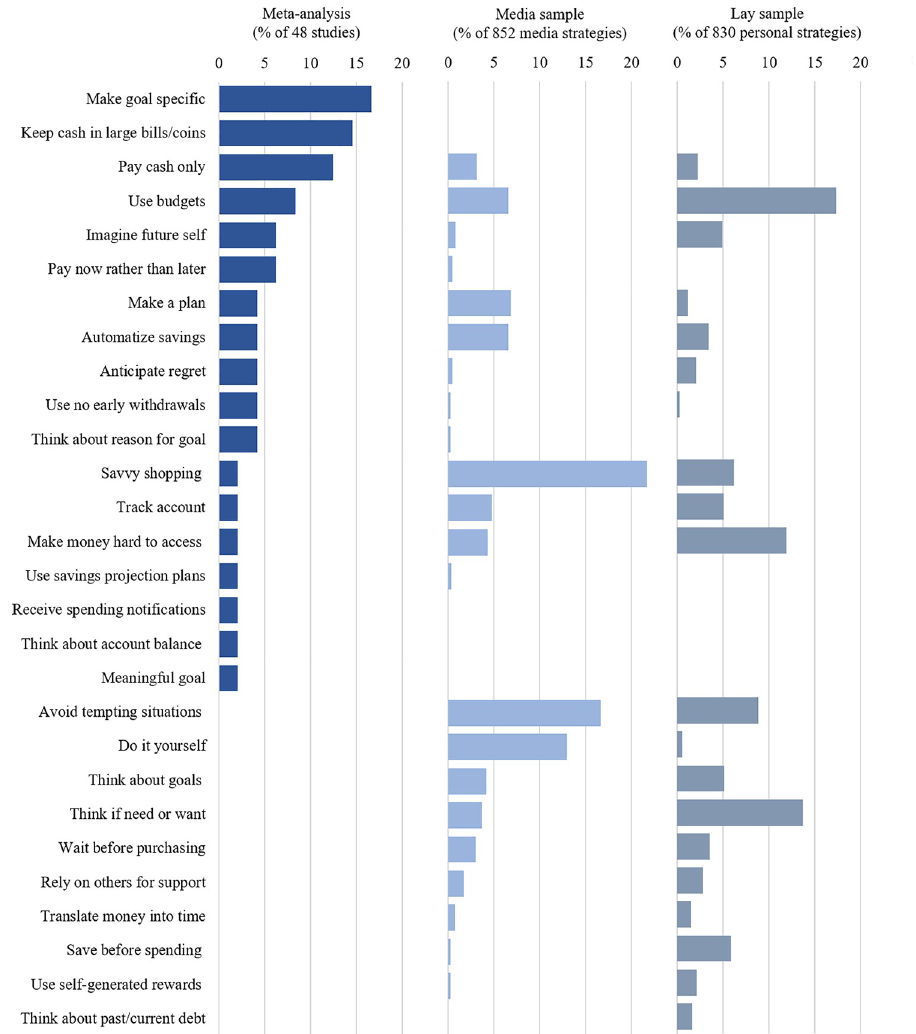
Fig 4. Panel graph showing prevalence of self-control strategies across the meta-analysis, media sample, and lay sample. Each panel shows the percentage of how often each strategy was mentioned by each perspective. Refer to Tables 1–3 for strategy